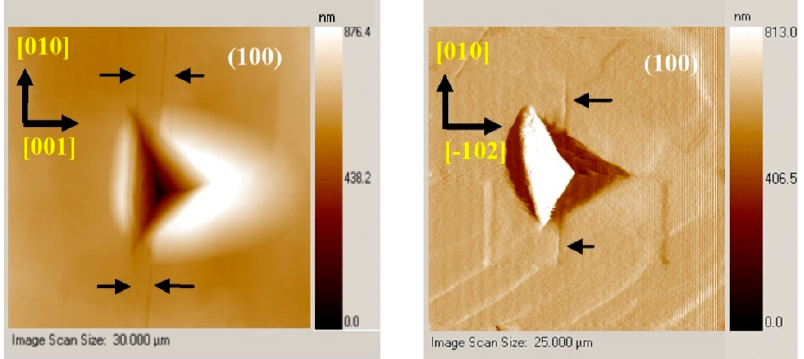
Figure 22. Irrespective of the indentation direction, the fracture is evident only in the <010> direction when indented on the {100} of aspirin polymorph I.